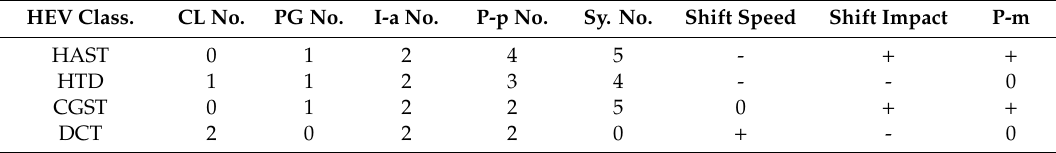
Figure 15. Type-d SEM PHPS architecture: ( a ) hybrid drive train (HDT); ( b ) Hitachi active shift transmission (HAST); ( c ) clutchless geared smart transmission (CGST). (Ms-G—multi-axis gearbox; FG—fixed gear; SM—synchromeshes; Ps—path switch; CL—clutch.). Table 3. Comparison of the three hybrid transmission systems and the dal clutch (DCT) system. HEV Class.